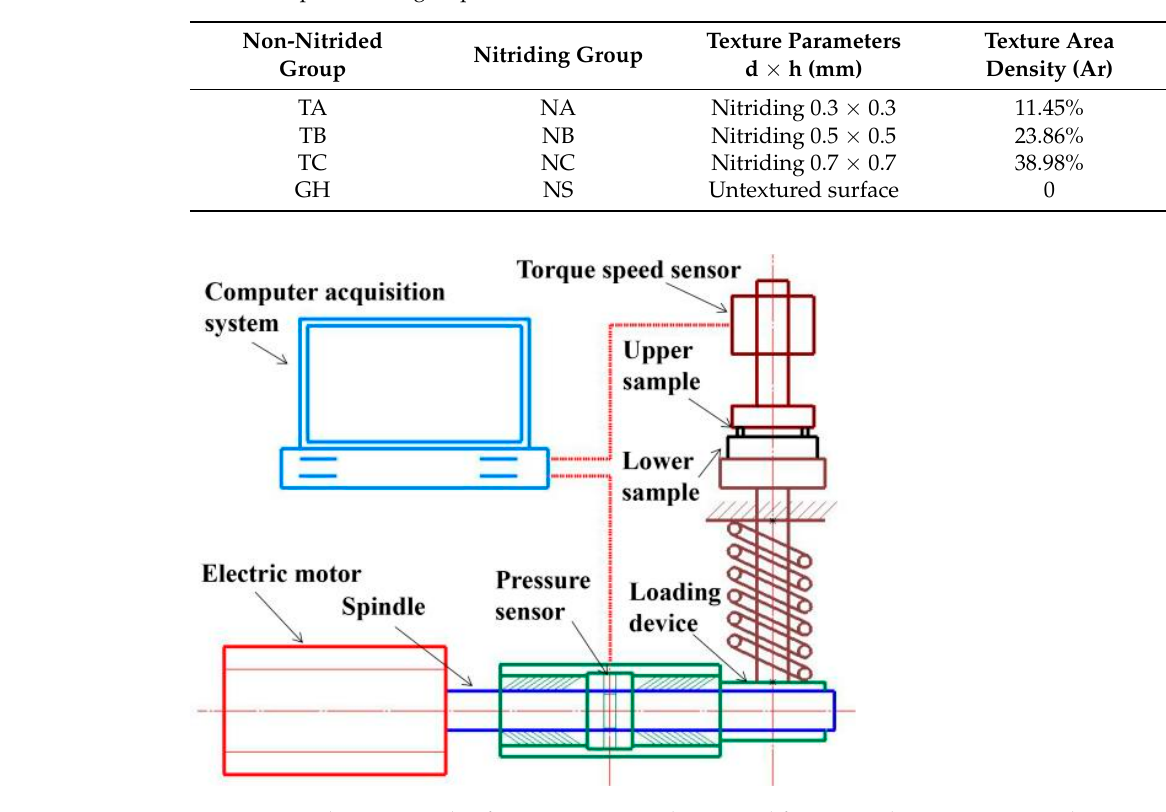
Figure 1. Triangular texture diagram. Table 2. Experimental group number.